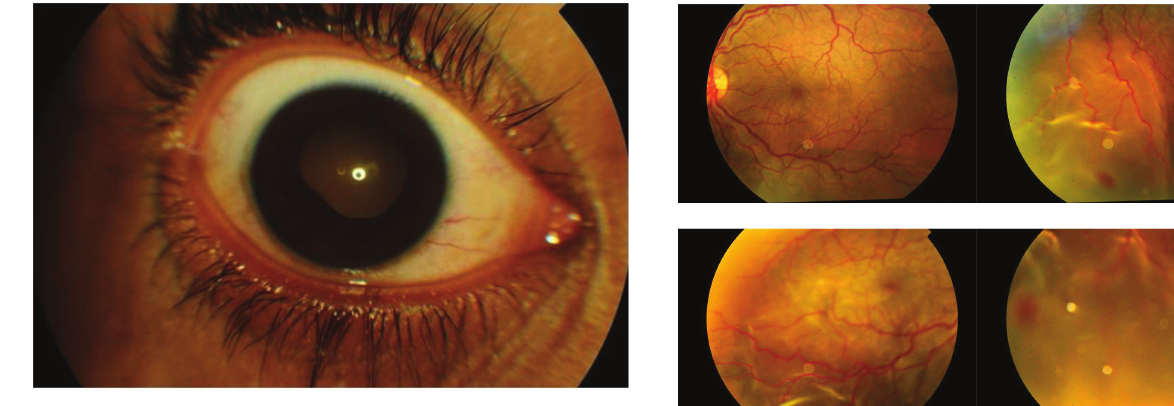
Figure 2. Anterior segment photograph of the right eye showing posterior synechiae.